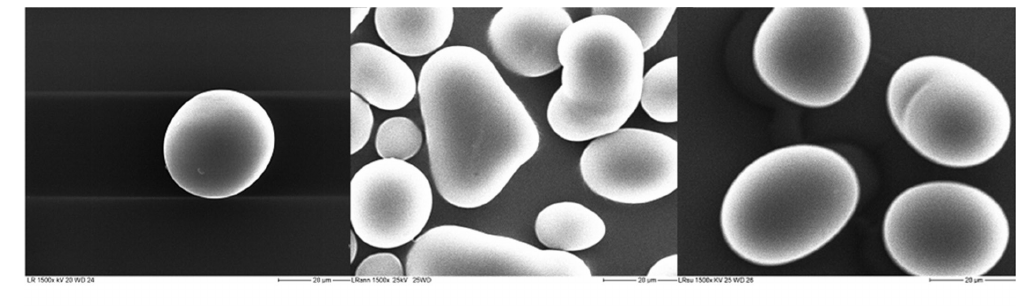
FIGURE 1 - SEM of Succinyl, Annealed, and Native Red Lima Bean Starches